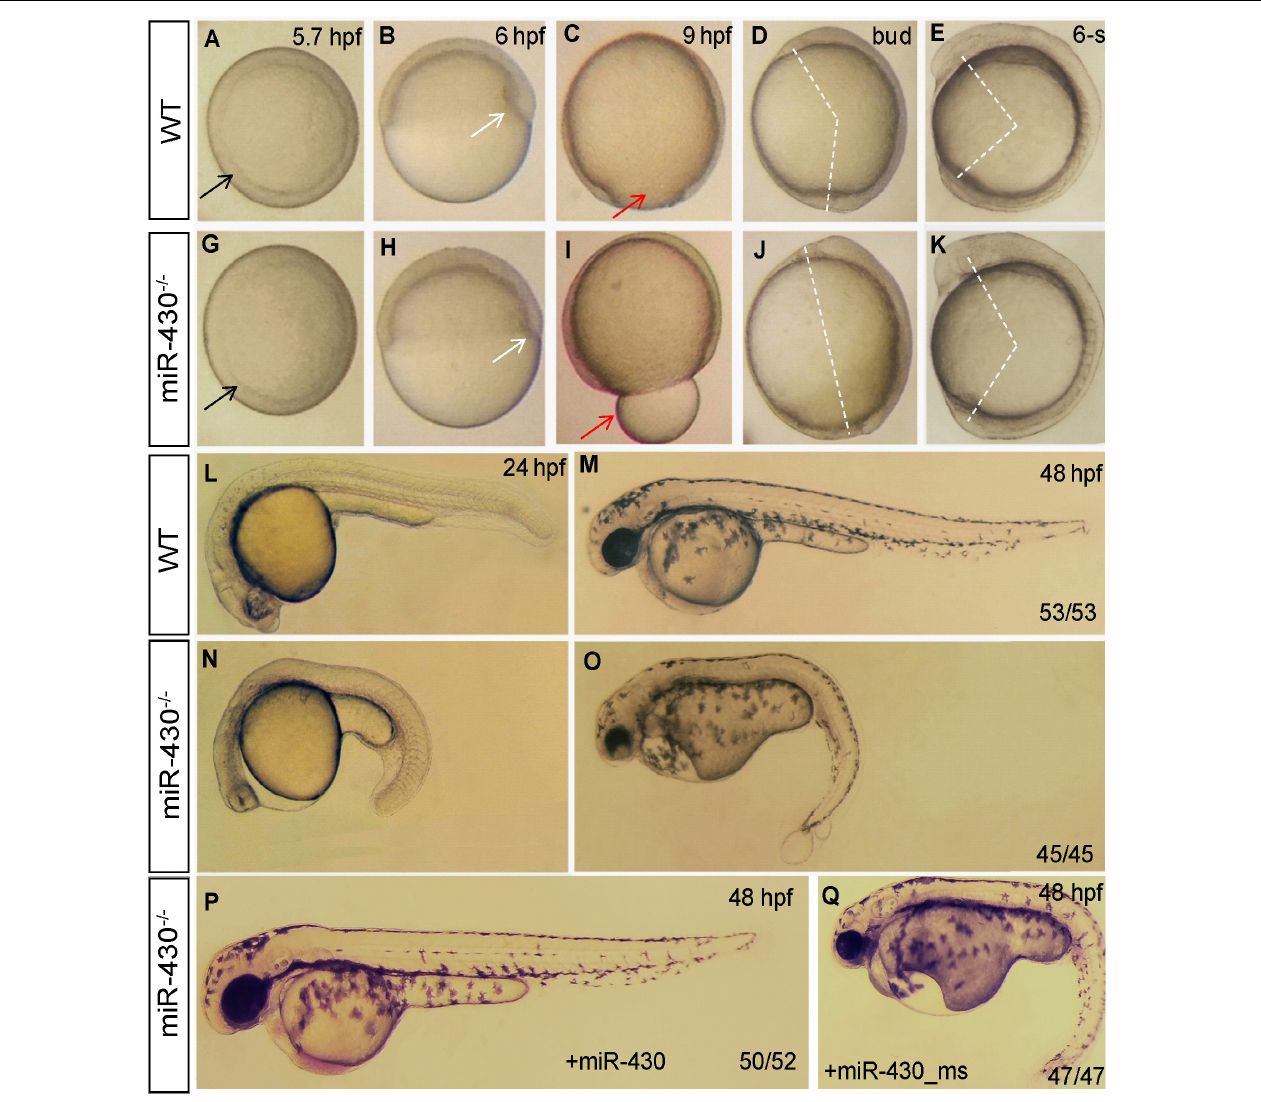
FIGURE 2 | Morphological defects in the miR-430 -deficient embryos. (A–O) The morphology of WT and miR-430 -deficient embryos. The phenotypes are fully penetrant. Formation of the germ ring (black arrows) and shield (white arrows) were delayed in the miR-430 − / − mutants (A,B,F,G) . The yolk was not enclosed by epiboly in the mutant at 9 hpf (C,H) . The extension of the anterior-posterior body axis was reduced in the miR-430 mutants (D,E,I,J) . The miR-430 mutants had no brain vesicles and lacked heart tissue and circulation (K,M) . Tail blisters were observed in the mutant at 48 hpf (L,N) . The miR-430 mimics but not the mismatched miR-430 with 2-nucleotide alterations could rescue the defects observed in the miR-430 mutants (O,P) . The ratios of observed phenotypes were indicated.